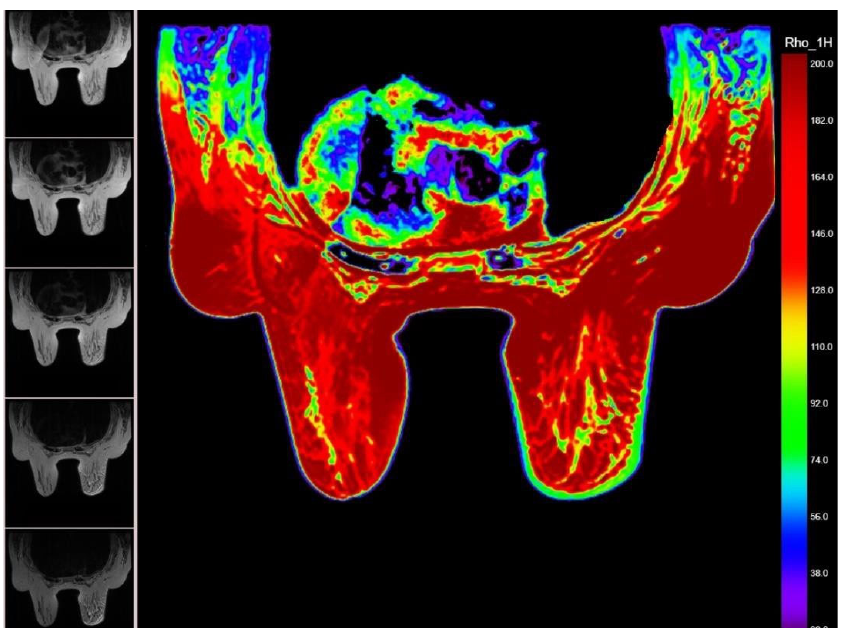
Figure 2. MR proton density map showing carcinomatous mastitis of the right breast with thickened skin and malignant interstitial edema (green; between 92–74 ms). The 5 different MR images used to obtain the relaxometry map are displayed on the left side.